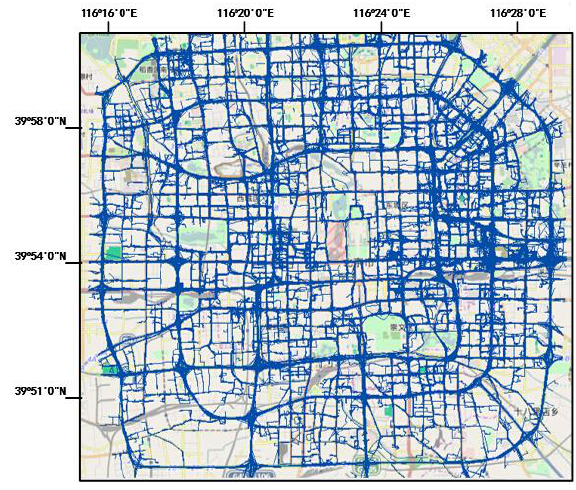
Figure 4. Study area and trajectory lines